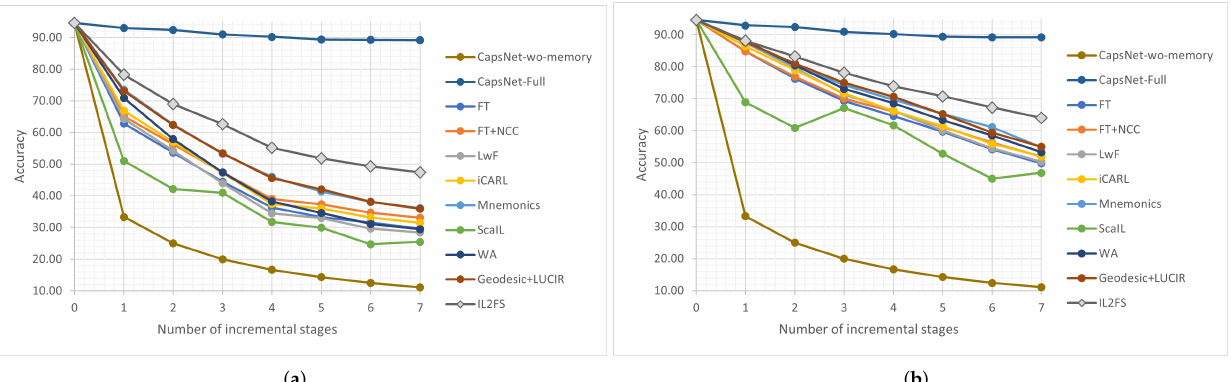
Figure 5. Effect of the number of incremental stages on the DREAMER dataset, using memory sizes of ( a ) 1% and ( b ) 5% of the full training dataset of each subject. We reported average accuracy in each incremental stage over all